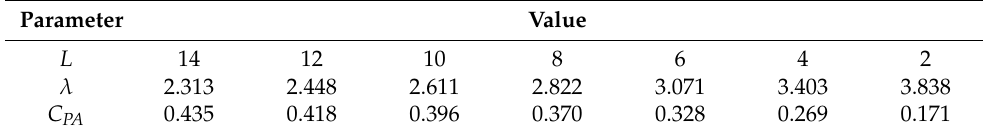
Figure 9. Averaged power coefficients of a stand-alone turbine. Table 4. Specific values of C PA corresponding to λ